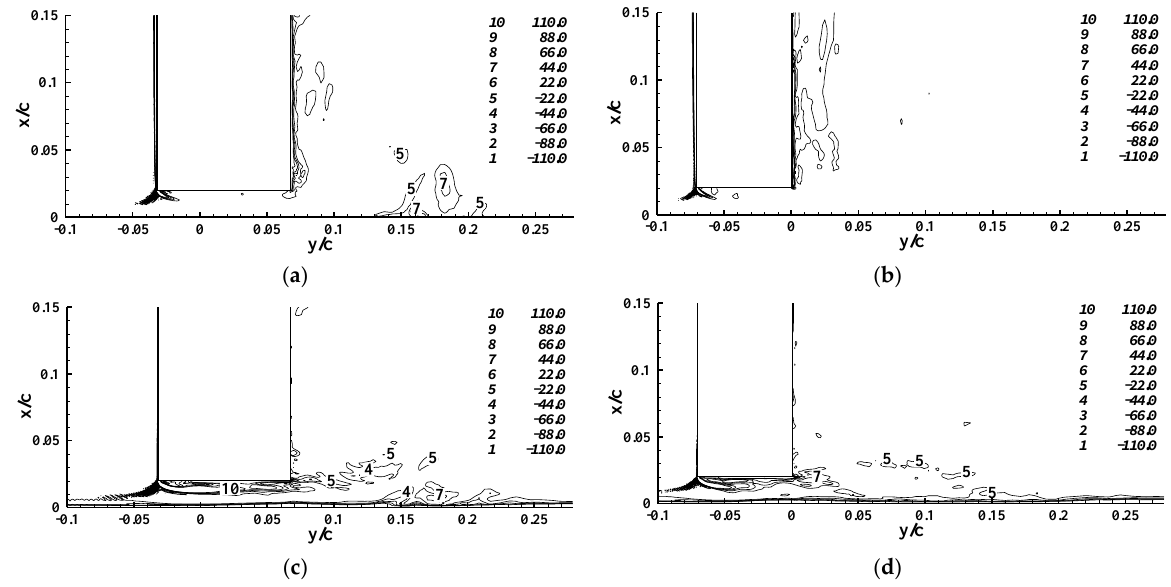
Figure 11. Contours of non-dimensional mean spanwise ( top ) and pitchwise ( bottom ) vorticity components in x-y planes: ( a , c ) for z / c = − 0.1, and ( b , d ) for z / c = 0.2.